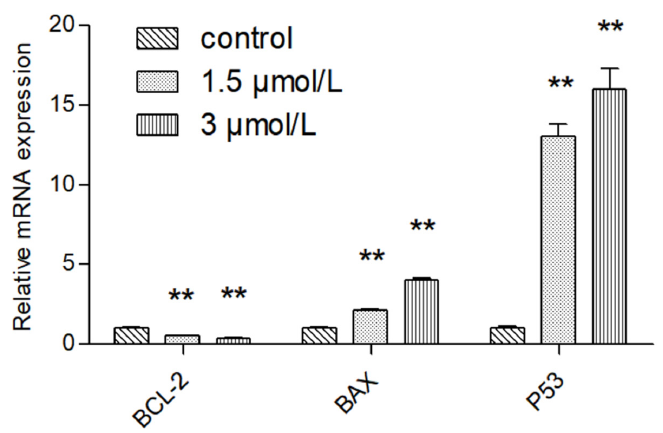
Figure 8. The effect of DTB on the expression of mitochondrial-related genes BCL-2, BAX, and TP53 in colon cancer cells LOVO. n = 3; compared with the blank group, ** p < 0.01, each data point represents the mean ± standard error.